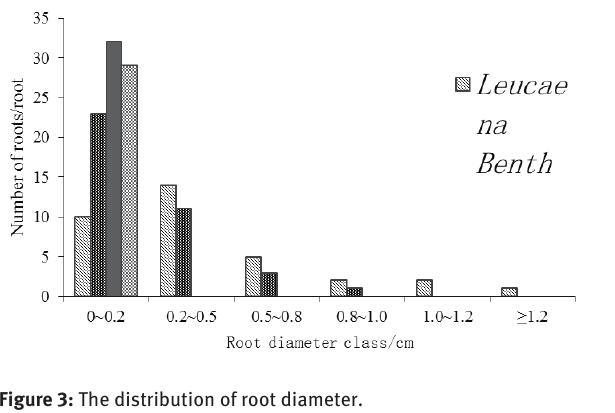
Figure 3: The distribution of root